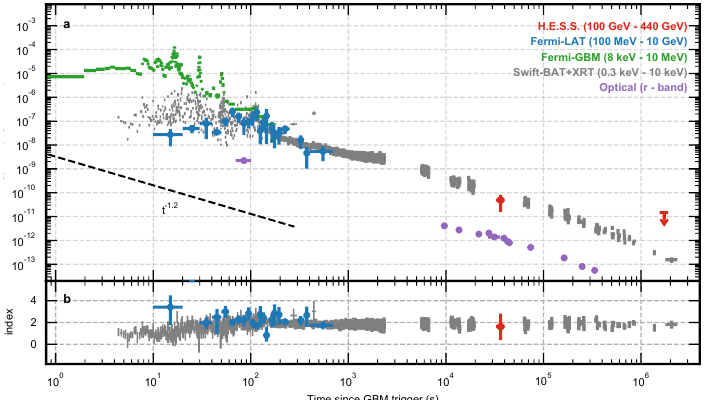
Figure 14. GRB180720B: broad-band light curves and photon index evolution including optical, X-ray and VHE data. For the late time H.E.S.S. observation (18 days after the trigger) an UL has been derived. A flux temporal decay with index 1.2 (similar to what observed in optical and X-ray) is also shown in black dashed line. From [4].